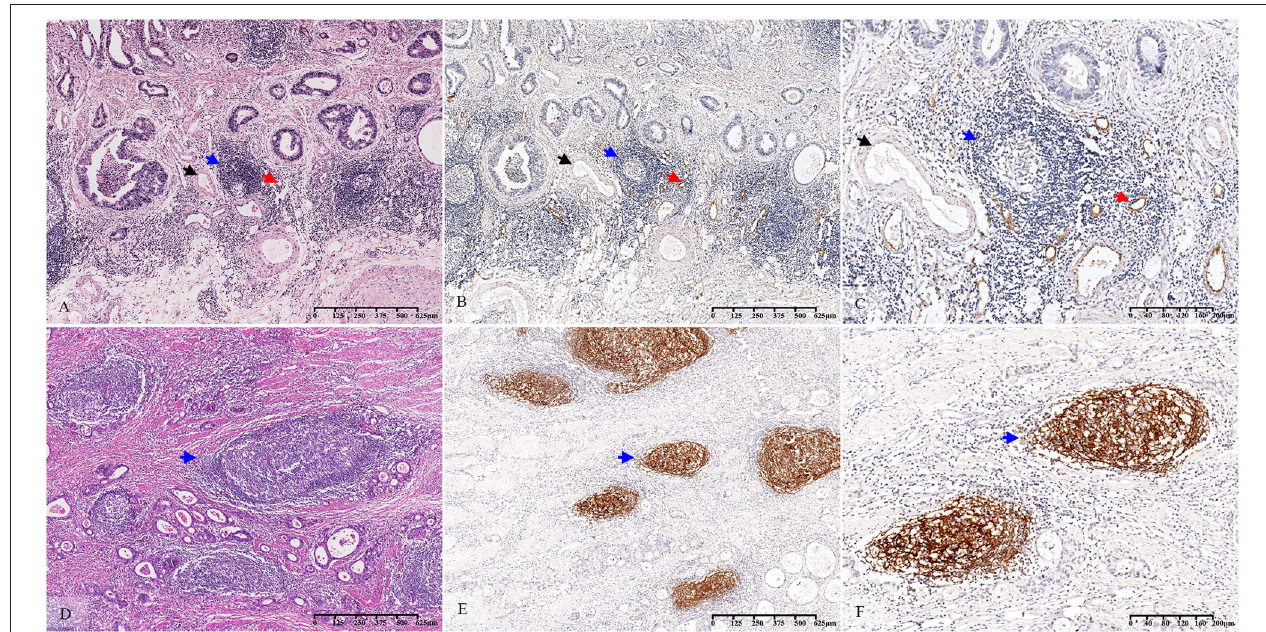
FIGURE 2 | Histopathological observation and immunohistochemical verification of TLS. The TLS present in GC tissue (A–D) (blue arrow). MECA-79 and CD21 were used to verify the accuracy of the morphological evaluation of TLS. HEVs (A–C) (red arrow, MECA-79 + ) and venules (A–C) (black arrow, MECA-79 − ) are shown closing around the TLS. CD21-marked FDCs (E,F) (blue arrow, CD21 + ) are observed in the TLS. TLS, tertiary lymphoid structure; GC, gastric cancer; HEVs, high endothelial venules; FDCs, follicular dendritic